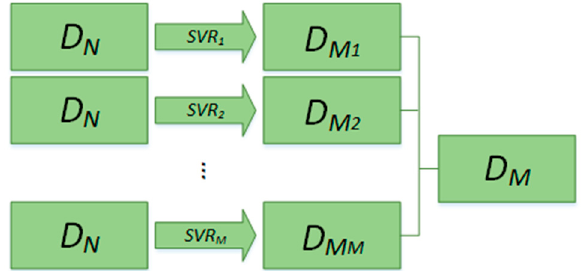
Figure 4. Principle of dimensionality reduction of LargeVis-based SVR. The low-dimensional data are obtained by combining the results of SVR in order.